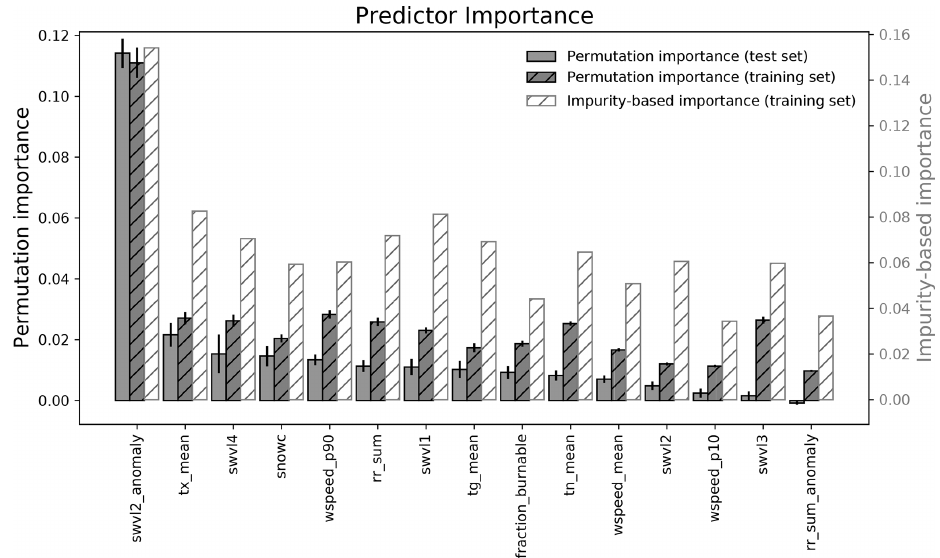
Figure 6. The importance of the predictors selected for the final data-driven model estimated using the permutation importance of the test and training set separately, as well as the impurity-based feature importance of the training set. The bar height of the permutation importance represents the mean, and the error bar represents the standard deviation of 10 random shuffles of each predictor. The bars are ordered by the permutation importance of the test set.